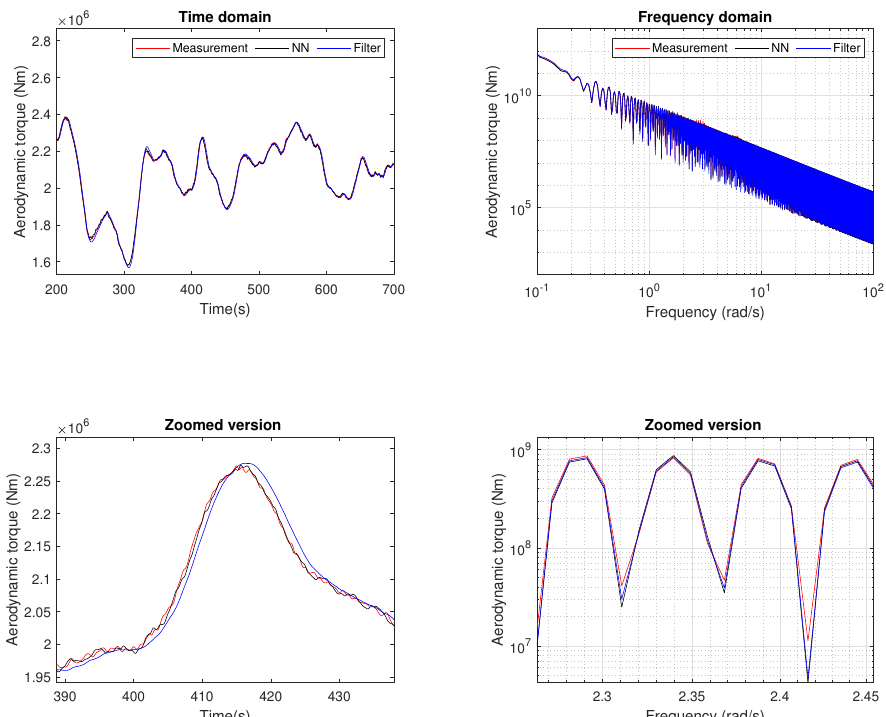
Figure 7. Scenario 1: Aerodynamic torque estimation from Turbine 5.